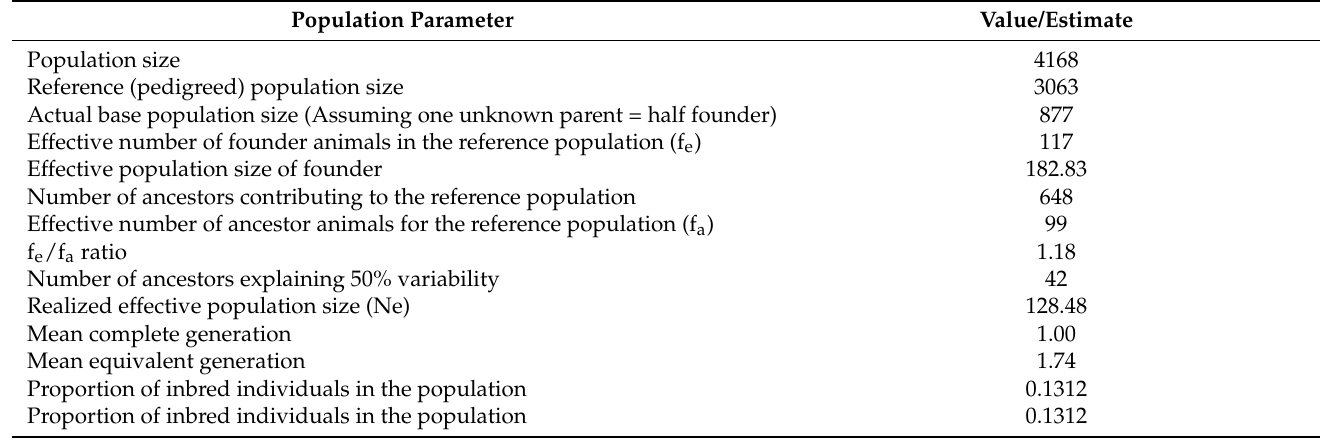
Table 5. Population parameters describing probability of gene origin in Mecheri sheep.